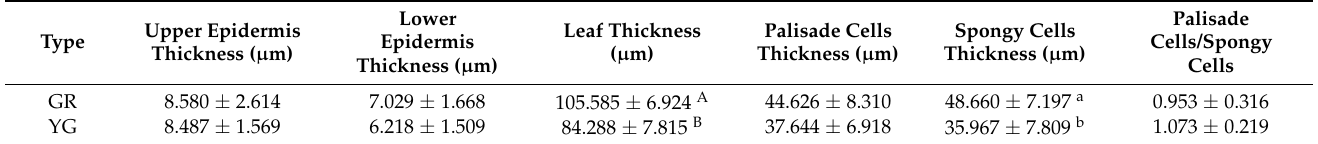
Figure 2. Microscopy observations of paraffin sections of P. tatarinowii ‘Jinyuyuan’ leaves. ( a ) P. tatarinowii ‘Jinyuyuan’ leaf. The red line indicates the cross-section position of the paraffin section. The green and yellow-green regions are separated along the main vein. ( b ) Microscopy observations of paraffin sections of P. tatarinowii ‘Jinyuyuan’ leaves. The red box is enlarged and displayed in ( c , d ). ( c ) Paraffin sections of the green region (GR). ( d ) Paraffin sections of the yellow-green region (YG). UE: upper epidermis, LE: lower epidermis, PC: palisade cells, SMC: spongy mesophyll cells, IA: intercellular air space. Table 2. Anatomic characteristics of different parts of leaves of P. tatarinowii